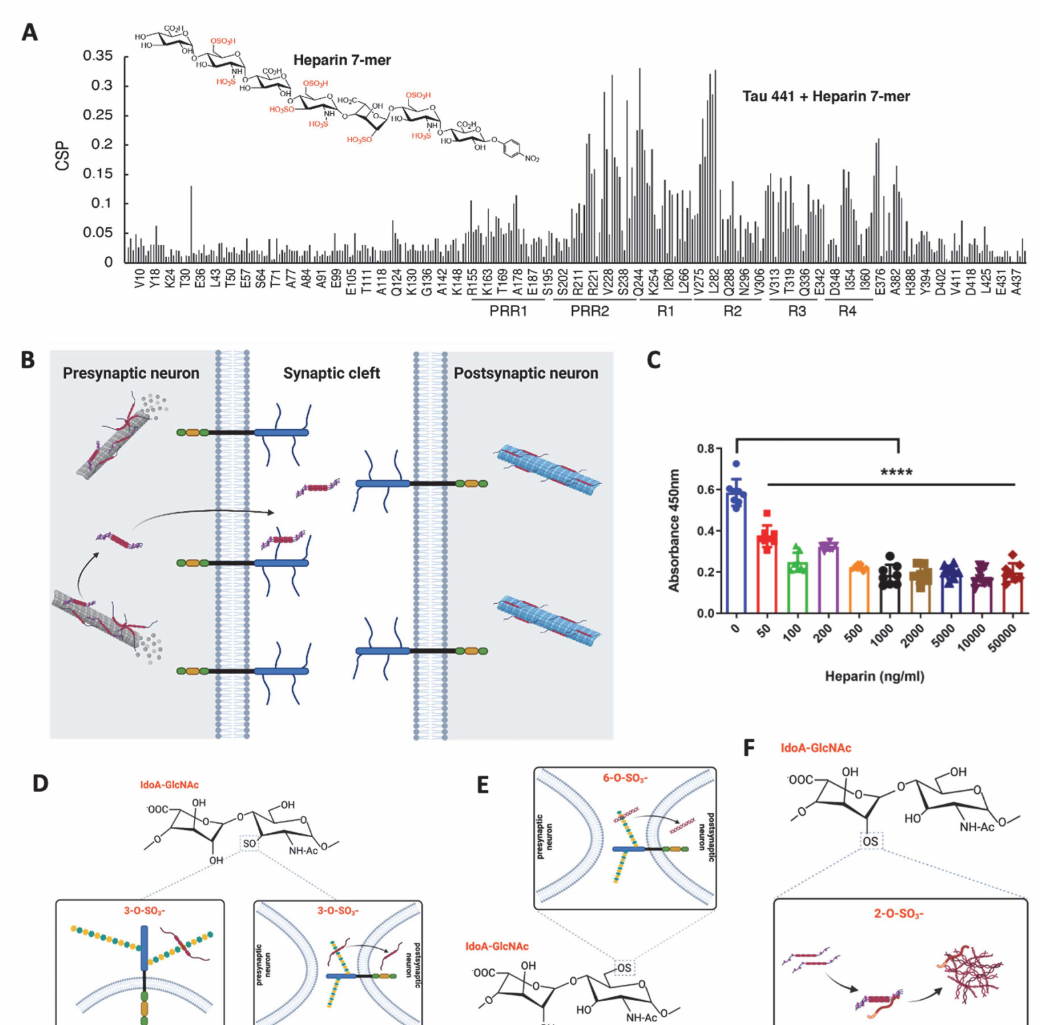
Figure 4. HS-tau interaction. ( A ). The major HS binding sites are located in R2 and PRR2 regions of tau, based on chemical shift perturbation (CS) caused by a heparin 7mer (adapted from Murray et al. [108]). ( B ). Tau secretion from the presynaptic neuron through an unconventional pathway is facilitated by cell surface HSPGs. ( C ). Tau at 50 ng/mL binds to the mouse lung endothelial cell surface. Heparin inhibits tau protein binding to the cell surface dose-dependently and reaches a plateau at 500 ng/mL. ****, p value < 0.0001 in ANOVA multiple group analysis ( D ). 3- O -sulfation of HS enhances tau protein cell surface binding and cellular uptake. ( E ). 6- O -sulfation of HS enhances tau protein cellular uptake. ( F ). 2- O -sulfation of HS enhances the tau